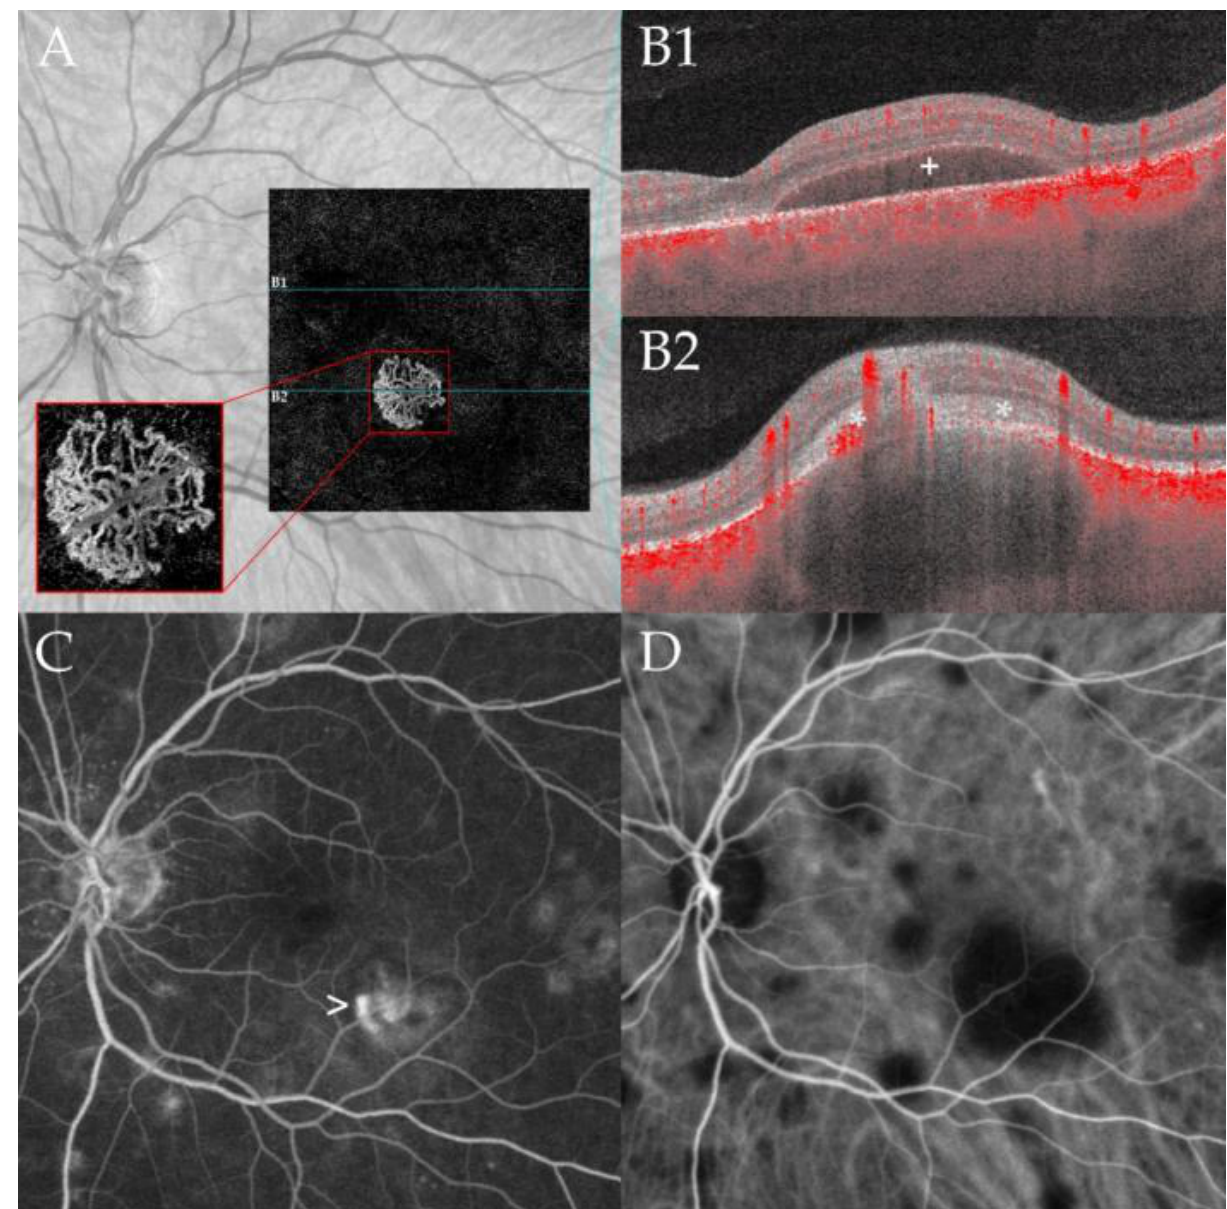
Figure 3. Macular neovascularization associated with choroidal granuloma. Optical coherence tomography angiography (OCTA, panel ( A )) of a 53-year-old male patient (case 4) at 36 months of follow-up demonstrating a macular neovascular vessels Type 1 in the en face OCTA scan of the outer retina choriocapillaris slab (red rectangle). Note the branching of many small capillaries and the presence of peripheral arcades in the higher magnification of the neovascular membrane. The corresponding B-scan with superimposed flow information (panel ( B1 , B2 )) demonstrates subretinal fluid ( B1 ) and subretinal hyperreflective material (*, ( B2 )) overlying a large choroidal granuloma. Note the subretinal hyperreflective material (*, ( B2 )) and the associated subretinal fluid (+, ( B1 )) leading to decreased vision. Multiple hyperfluorescent lesions at the posterior pole and middle periphery are visible in fluoresceine angiography (FA, panel ( C )). Note the leakage of the lesion at the posterior pole related to the active neovascularization (arrow). Indocyanine green angiography (ICGA, panel ( D )) shows disseminated hypofluorescent choroidal lesions including the large granuloma associated with the CNV; the lesions are more numerous compared to FA.